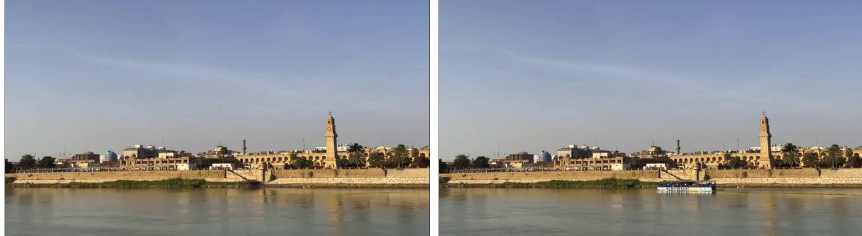
Fig. 2. Frame samples before and after the emergence of the target moving ferry